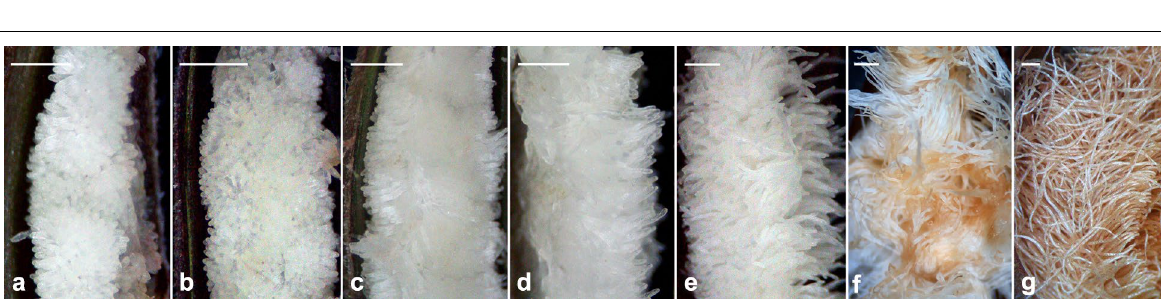
Fig. 3 Light micrographs of developing ovules and seeds of A. roxburghii . a 0 DAP, b 5 DAP, c 10 DAP, d 15 DAP, e 20 DAP, f 30 DAP and g at 40 DAP. Scale bar 0.5 =